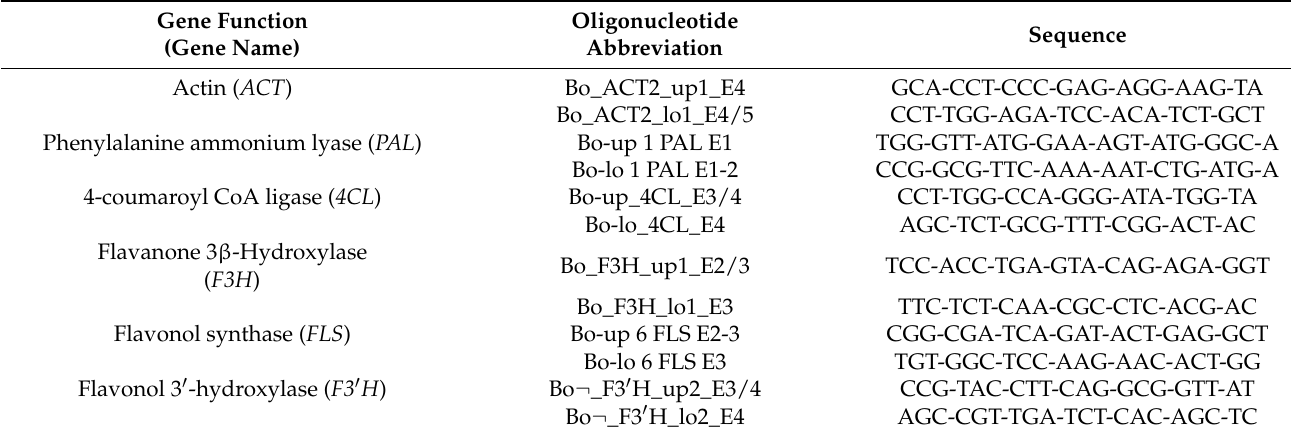
Table 1. Oligonucleotide primers for genes of the phenolprpanoid biosynthesis and the reference gene based on the genome of Brassica oleracea for gene expression analysis by semiquantitative real-time